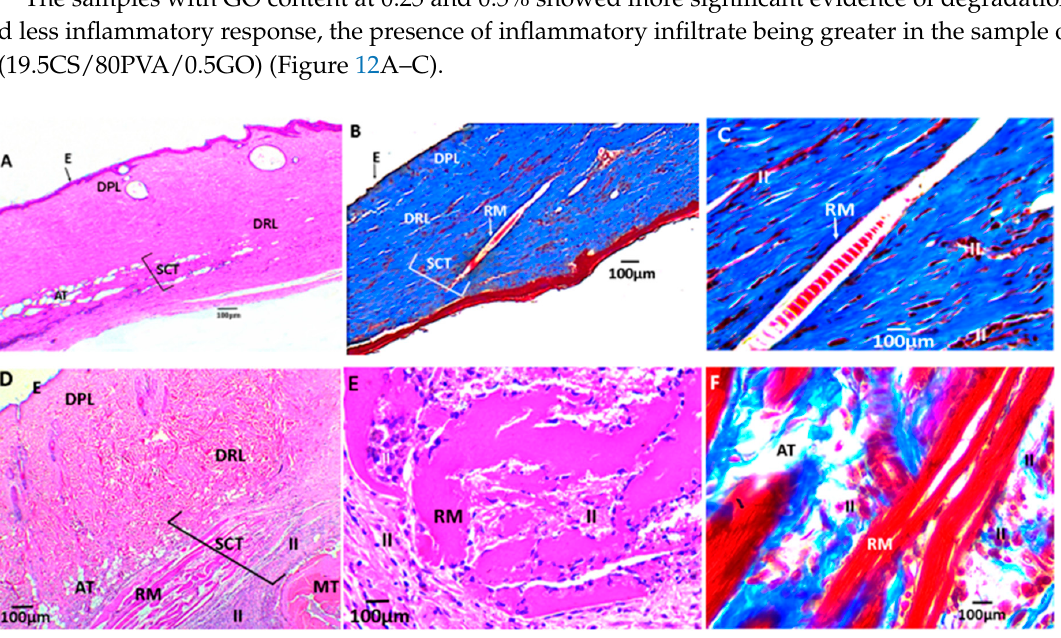
Figure 12. Histological analysis of experimental samples: ( A – C ) formulation F2 (CS/PVA/GO